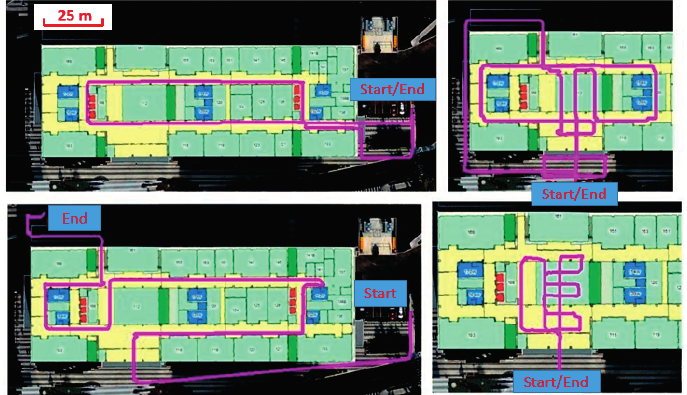
Figure 4. Trajectories used to generate WiFi and magnetic databases (DBs) at the Energy Environment Experiential Learning